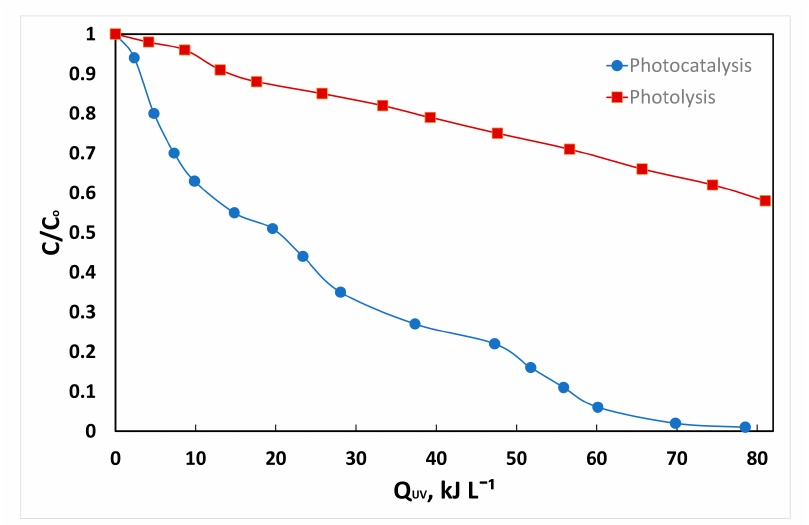
Figure 9. Photocatalysis and photolysis using a SS flat reactor in pilot scale of 300 µ g/L SMX in deionized water and inherent pH in the presence/absence of 125 mg/L [0.50